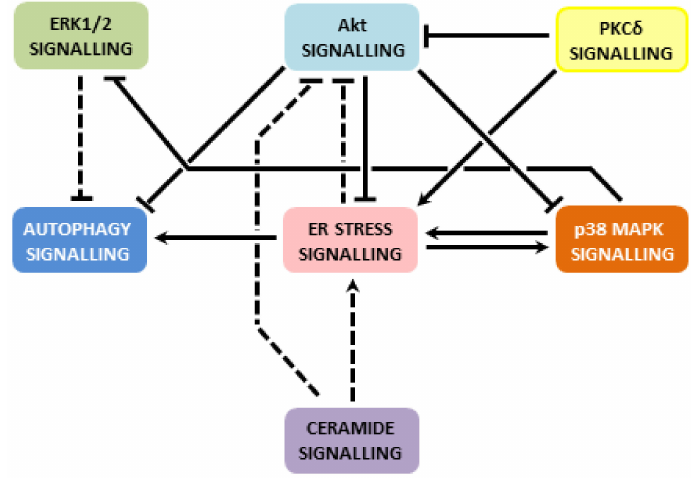
Figure 3. Suggested signalling pathway cross talks during apoptosis induction by saturated fatty acids in pancreatic β -cells. Dashed lines show a relationship well proved only in other cell types.